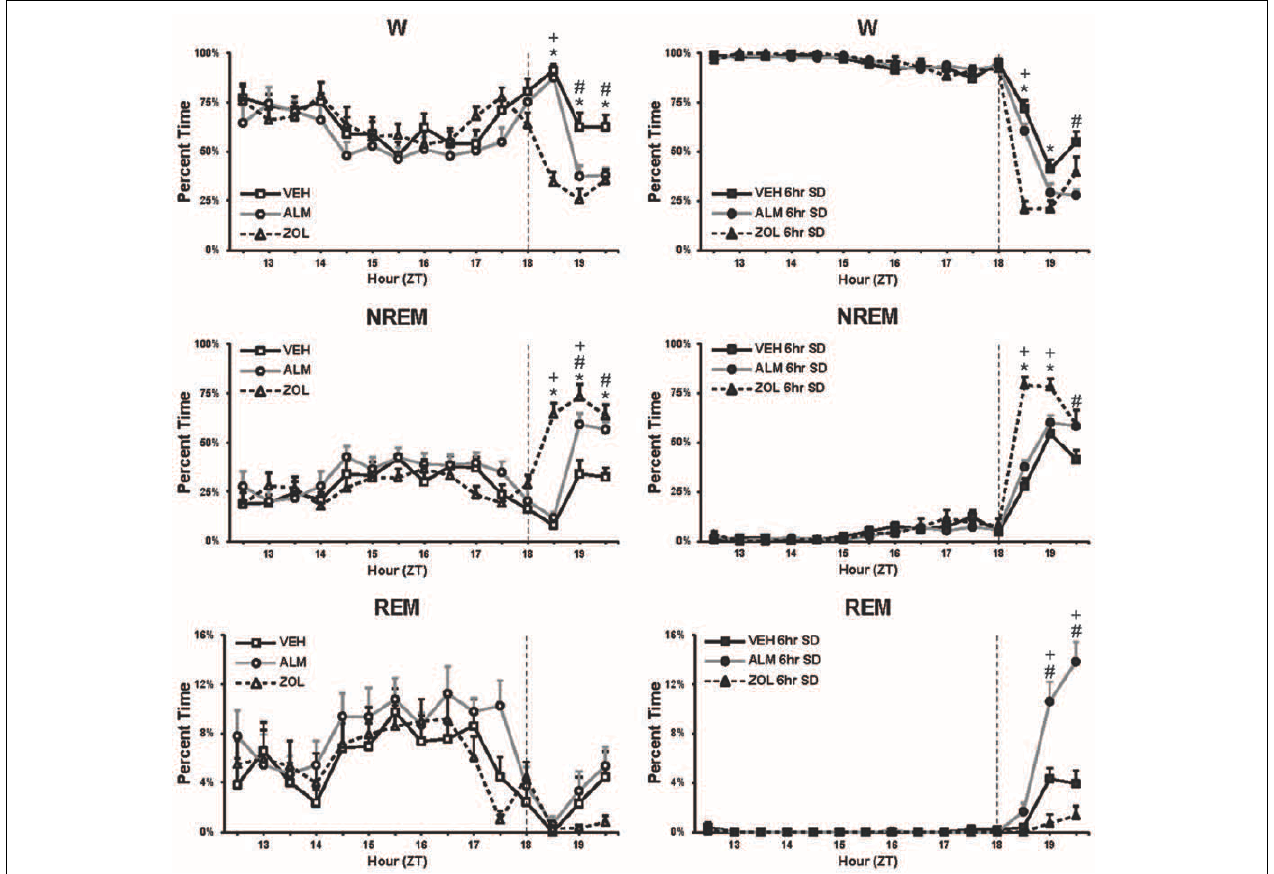
FIGURE 2 | Percent time spent in W, NREM, and REM during baseline (left panels) and during 6h SD (right panels). The vertical line in each panel at ZT18 depicts the time of drug administration. At the end of the recording time displayed in these panels, rats were